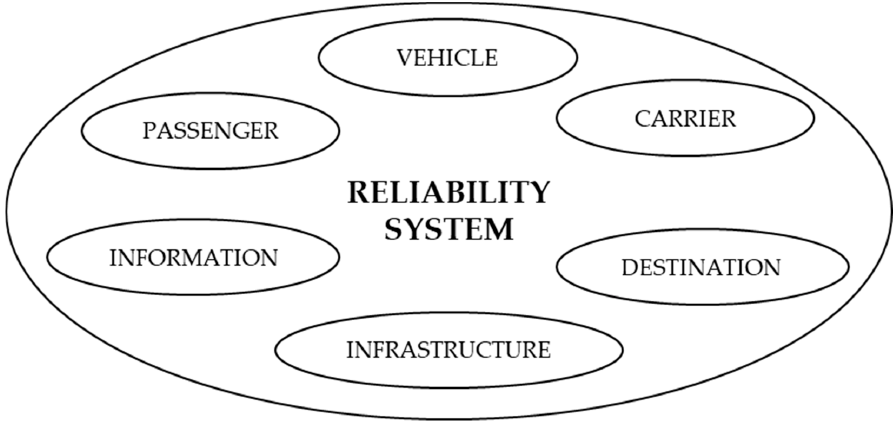
Figure 1. Components of a transport process